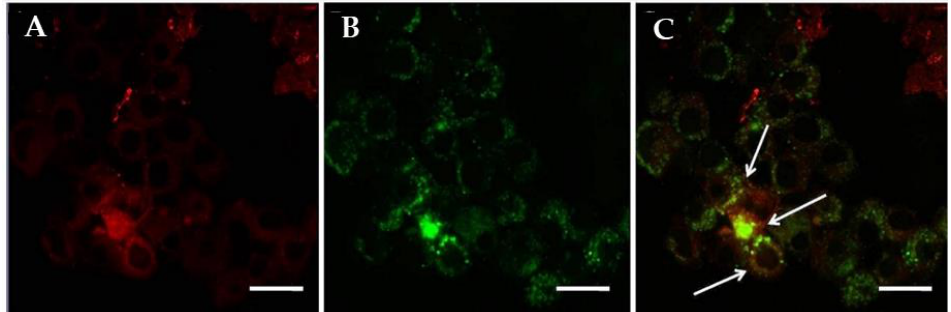
Figure 2. Confocal scanning laser photomicrograph exhibiting the endosomal internalization of SPG-ODN 1826 nanovehicles within J774A.1. ( A ) The plasma membrane is red due to the stain of FM 4-64 whereas ( B ) the internalized SPG-ODN 1826 nanovehicles appear green due to the presence of tagged FAM-CpG ODN 1826. ( C ) Endosomal localization of SPGNPs within alveolar macrophages J774A.1 cells was tracked using yellow fluorescence created by the overlay images of FM4-54 and FAM stain that resulted in a yellow color (indicated by arrows). Magnification = 32X, scale bar = 20 μm.